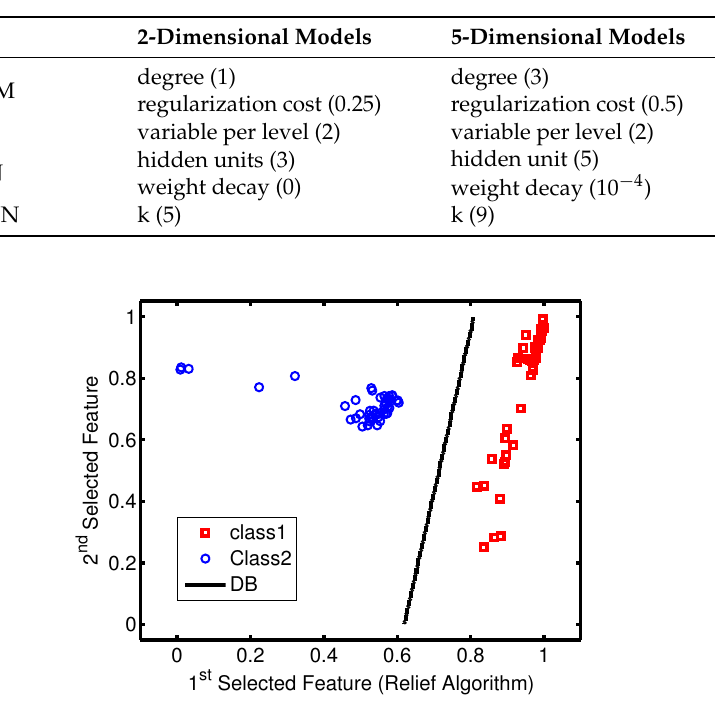
Figure 10. Kappa density plots for the implemented classifiers using two-dimensional data set using relief feature selection. ( a ) KNN ( b ) RF; ( c ) NN; ( d ) SVM. Table 4. Configurations of the classifiers built using the data sets selected using relief feature selection.